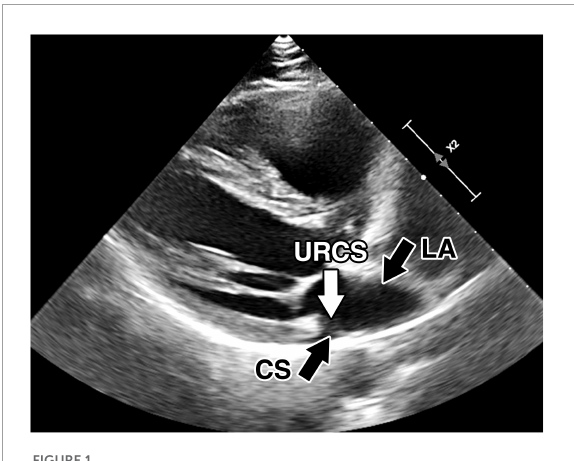
FIGURE1 Preoperative transthoracic echocardiography. Preoperative transthoracic echocardiography images of the unroofed coronary sinus. Direct communication between the coronary sinus and left atrium. CS, coronary sinus; LA, left atrium; URCS, unroofed coronary sinus.